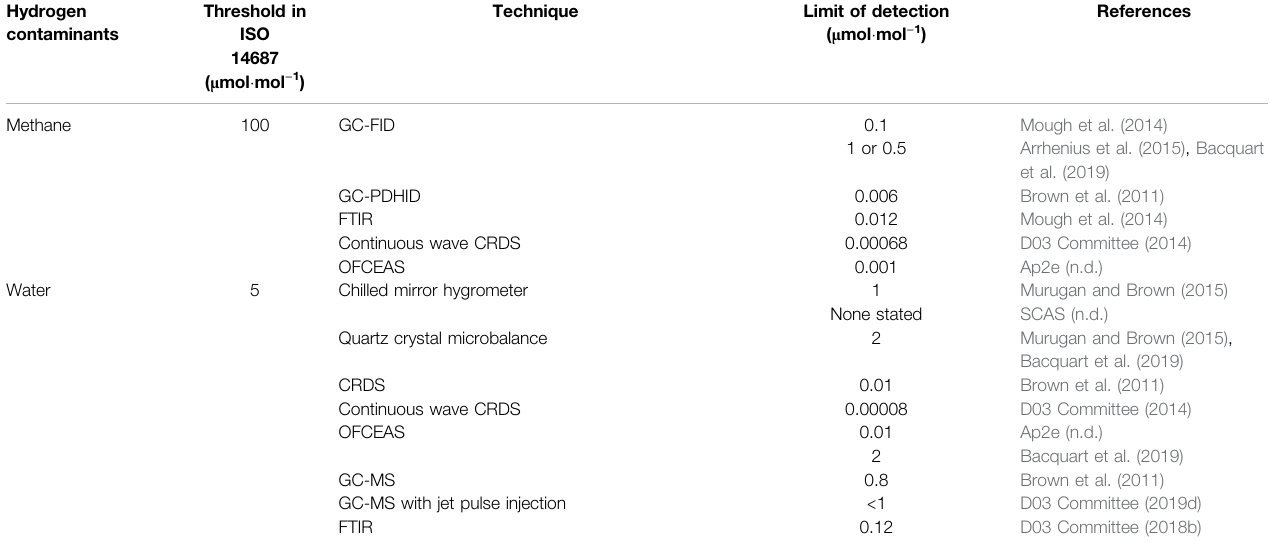
TABLE 10 | ( Continued ) Analytical methods from the bibliographical study per impurity with detection limit above the control